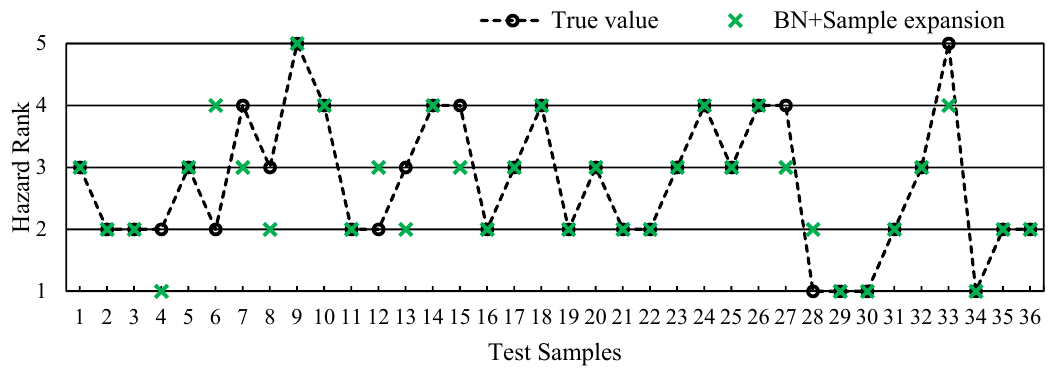
Figure 6. Assessment results of testing sample.